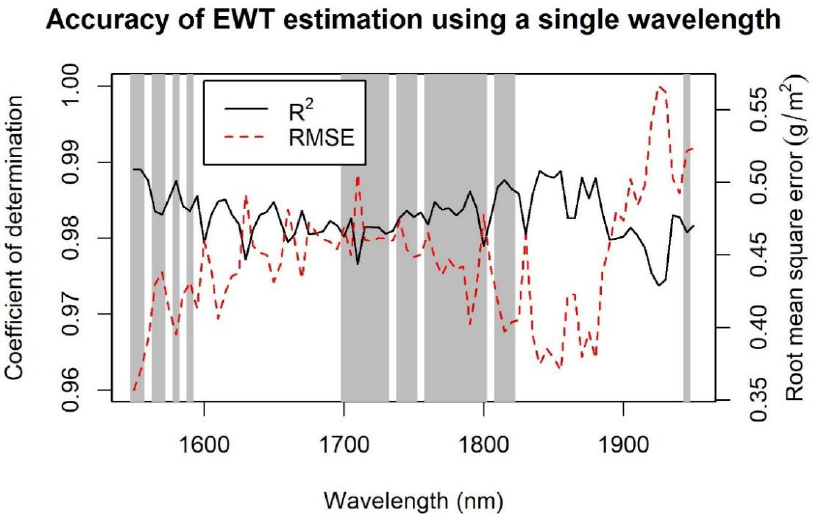
Figure 2. The mean coefficient of determination (R 2 ) and root mean square error (RMSE) for linear regression models developed between leaf reflectance of each wavelength ( x -axis) and equivalent water thickness (EWT) for all four measured leaves after petiole removal. The shaded areas show wavelengths that were not sensitive to water vapor concentration ( p > 0.05).